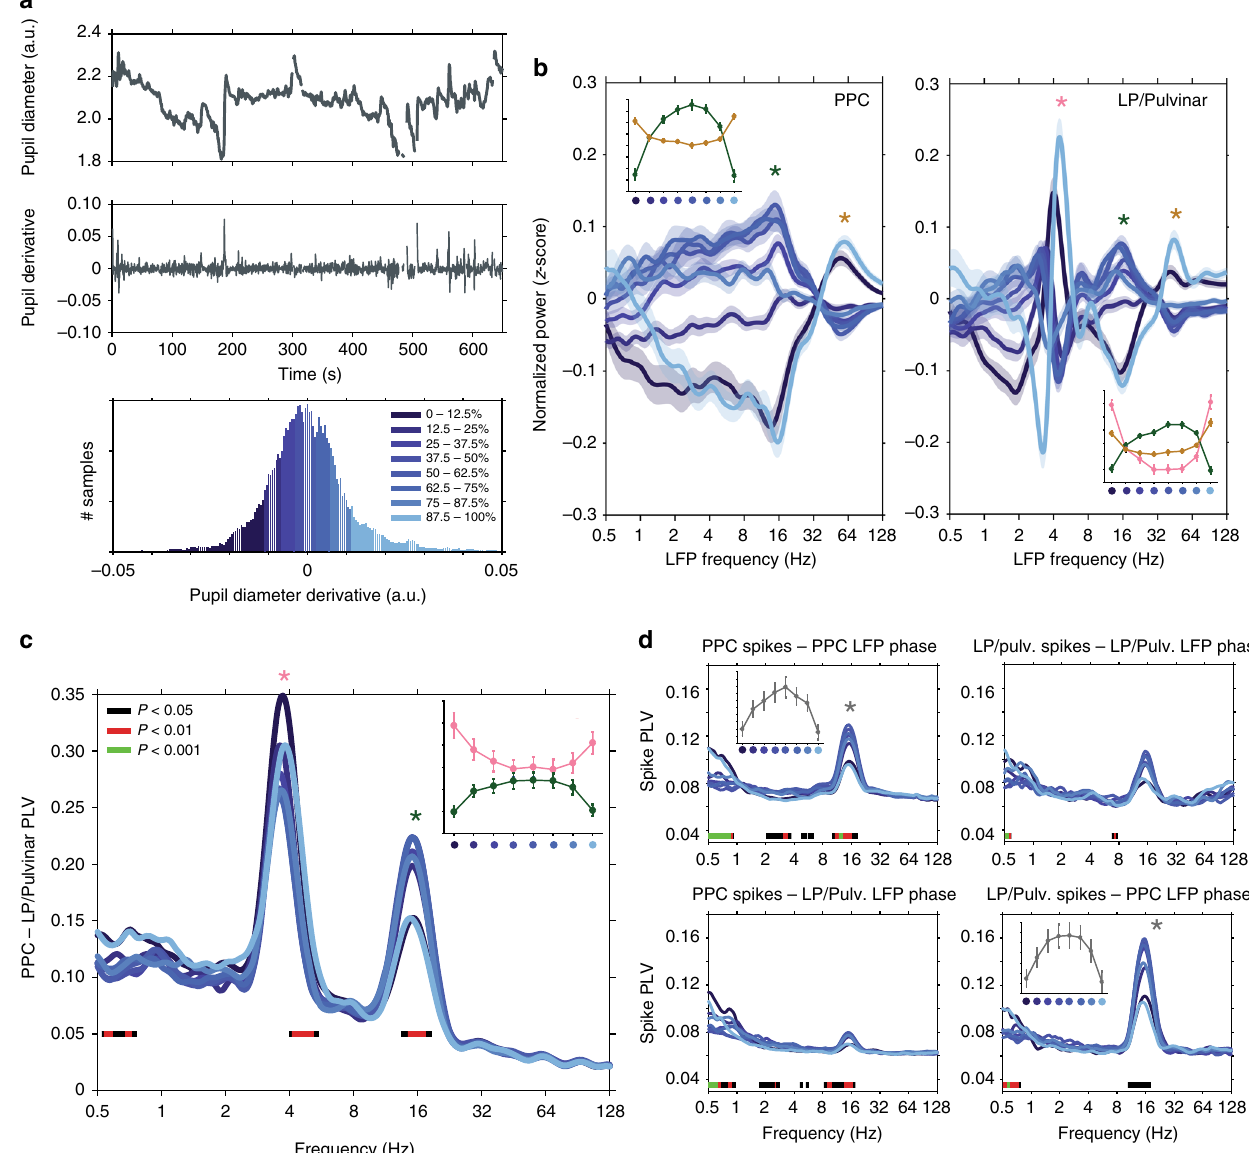
Fig. 8 Rapid fl uctuations in pupil diameter correlate with the reorganization of thalamo-cortical functional connectivity. a Raw pupil diameter (top) and pupil diameter derivative (middle) traces for one example recording (blinks have been removed from trace), and a histogram of pupil derivative time series broken into eight bins of equal size (bottom). Dark colors correspond to rapid pupil constriction, light colors correspond to rapid pupil dilation, and intermediate colors correspond to epochs of little change in pupil diameter. b The mean (±SEM) z -scored LFP power in PPC (left) and LP/Pulvinar (right) as a function of carrier frequency across pupil derivative bins. The insets in each fi gure illustrate how LFP power in theta, alpha, and gamma frequency bands changes across pupil derivative bins (frequency band indicated by asterisk). c PLV measured between LP/Pulvinar and PPC as a function of LFP frequency and the derivative of pupil diameter. d The phase synchronization (PLV) of spiking activity to LFP rhythms recorded within the same brain structure (top row), as well as between regions (bottom row) as a function of pupil derivative. Signi fi cant modulation of PLV and spike PLV across pupil derivative bins is indicated by color bars plotted below traces (one-way ANOVA, FDR-corrected P -values). Note the distinctive ‘ U ’ and inverted ‘ U ’ shape of many inset fi gures, indicating alpha synchronization/power is maximized during epochs of constant pupil diameter, and theta synchronization/power is maximized during epochs of rapid change in pupil